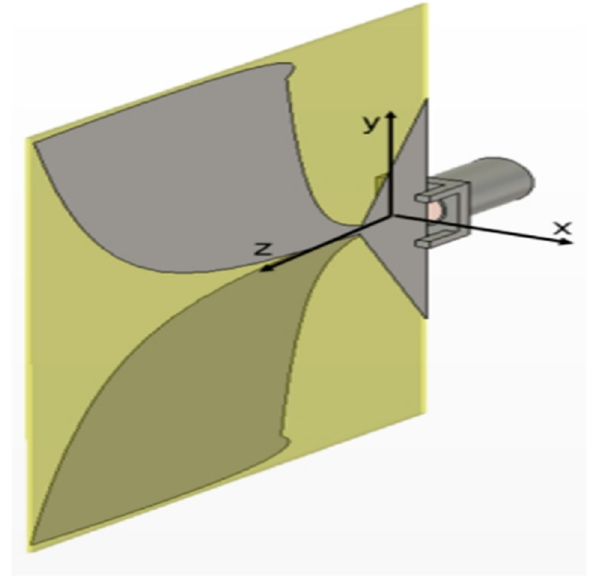
Figure 10. Vivaldi antenna